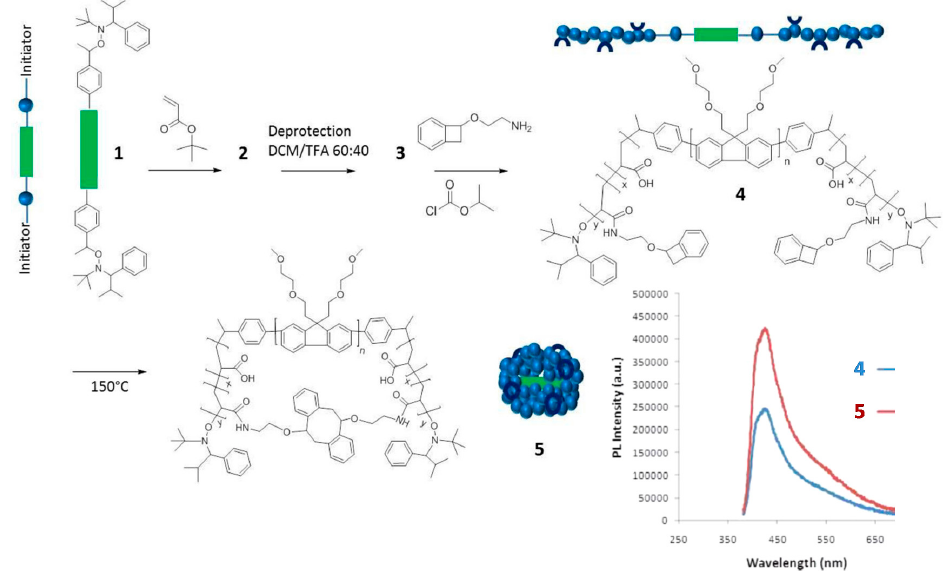
Figure 4. Synthesis of water-soluble fluorescent SCNPs ( 5 ) from a precursor polymer ( 4 ) containing a polyfluorene block (depicted in green) via intramolecular single-chain folding/collapse at 150 °C. The values of photoluminescence (PL) quantum efficiency of 4 and 5 (both with maximum PL intensity at 438 nm) were 2.8% and 5.1%, respectively (reprinted from [34] with permission, Copyright American Chemical Society, 2013).